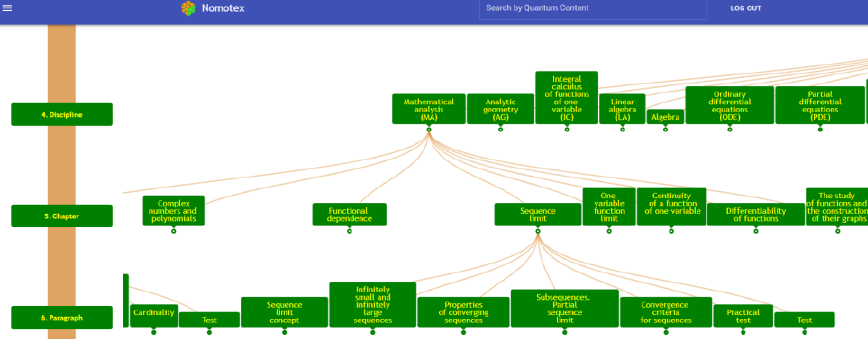
Fig. 3. The “Knowledge Base” DLS “NOMOTEX”.